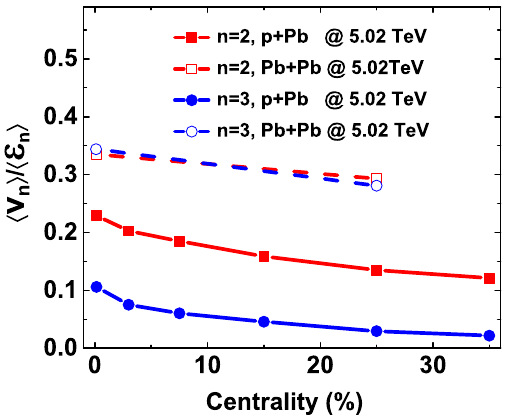
Fig. 13 (cid:2) v n (cid:3) / (cid:2) (cid:12) n (cid:3) ratio as a function of centrality class in 5.02 TeV p + Pb collisions for n = 2 and 3, compared to calculations in Ref. [15] in 5.02 TeV Pb + Pb collisions